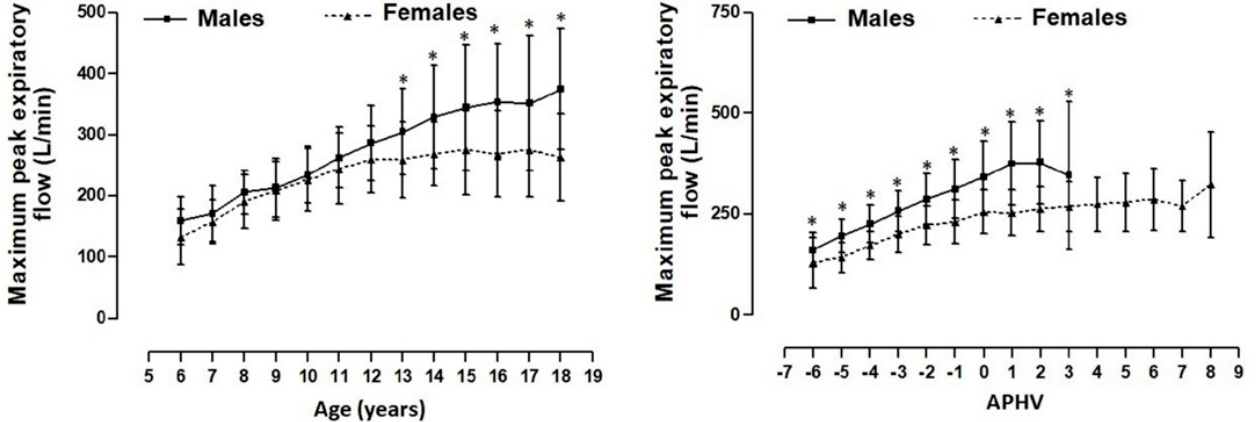
Figure 3. MEF values based on chronological age and maturation (APHV). Legend: * significant difference ( p < 0.05) related to females.